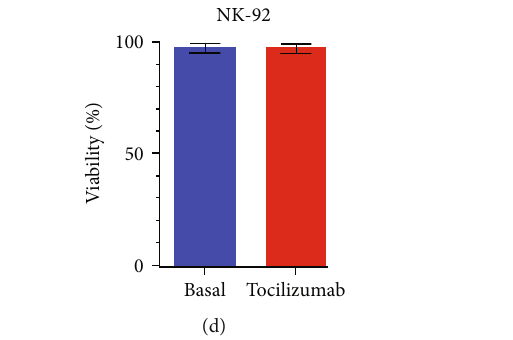
Figure 4: The combined use of stattic and tocilizumab increases the expression of NKp46 and decreases the expression of TIGIT in NK-92 cells. The NK-92 cells were cultured and treated with Stt at 3 μ M and 10 μ g/mL of Tcz for 24 hours. (a) Analysis strategy was used for evaluating the e ff ectiveness of treatments on viability and receptor expression. (b) Use of Stt above 5 μ M causes a signi fi cant decrease in the viability of NK-92 cells. The data are shown as the mean ± SD . ∗ p < 0 : 05 , ∗∗ p < 0 : 01 , ∗∗∗ p < 0 : 001 ; (unpaired t -test) against the basal group. (c, d) Treated groups with Stt and Tcz show a decrease in TIGIT and an increase in NKp46 in the percentage of positive cells and MFI; additionally, a signi fi cant decrease in NKp44 was only observed in the MFI. Data are shown as the mean ± SD . ∗ p < 0 : 05 , ∗∗ p < 0 : 01 , ∗∗∗ p < 0 : 001 (ANOVA with Bonferroni multiple comparison test). All experiments were repeated at least three times. Stt: stattic; Tcz: